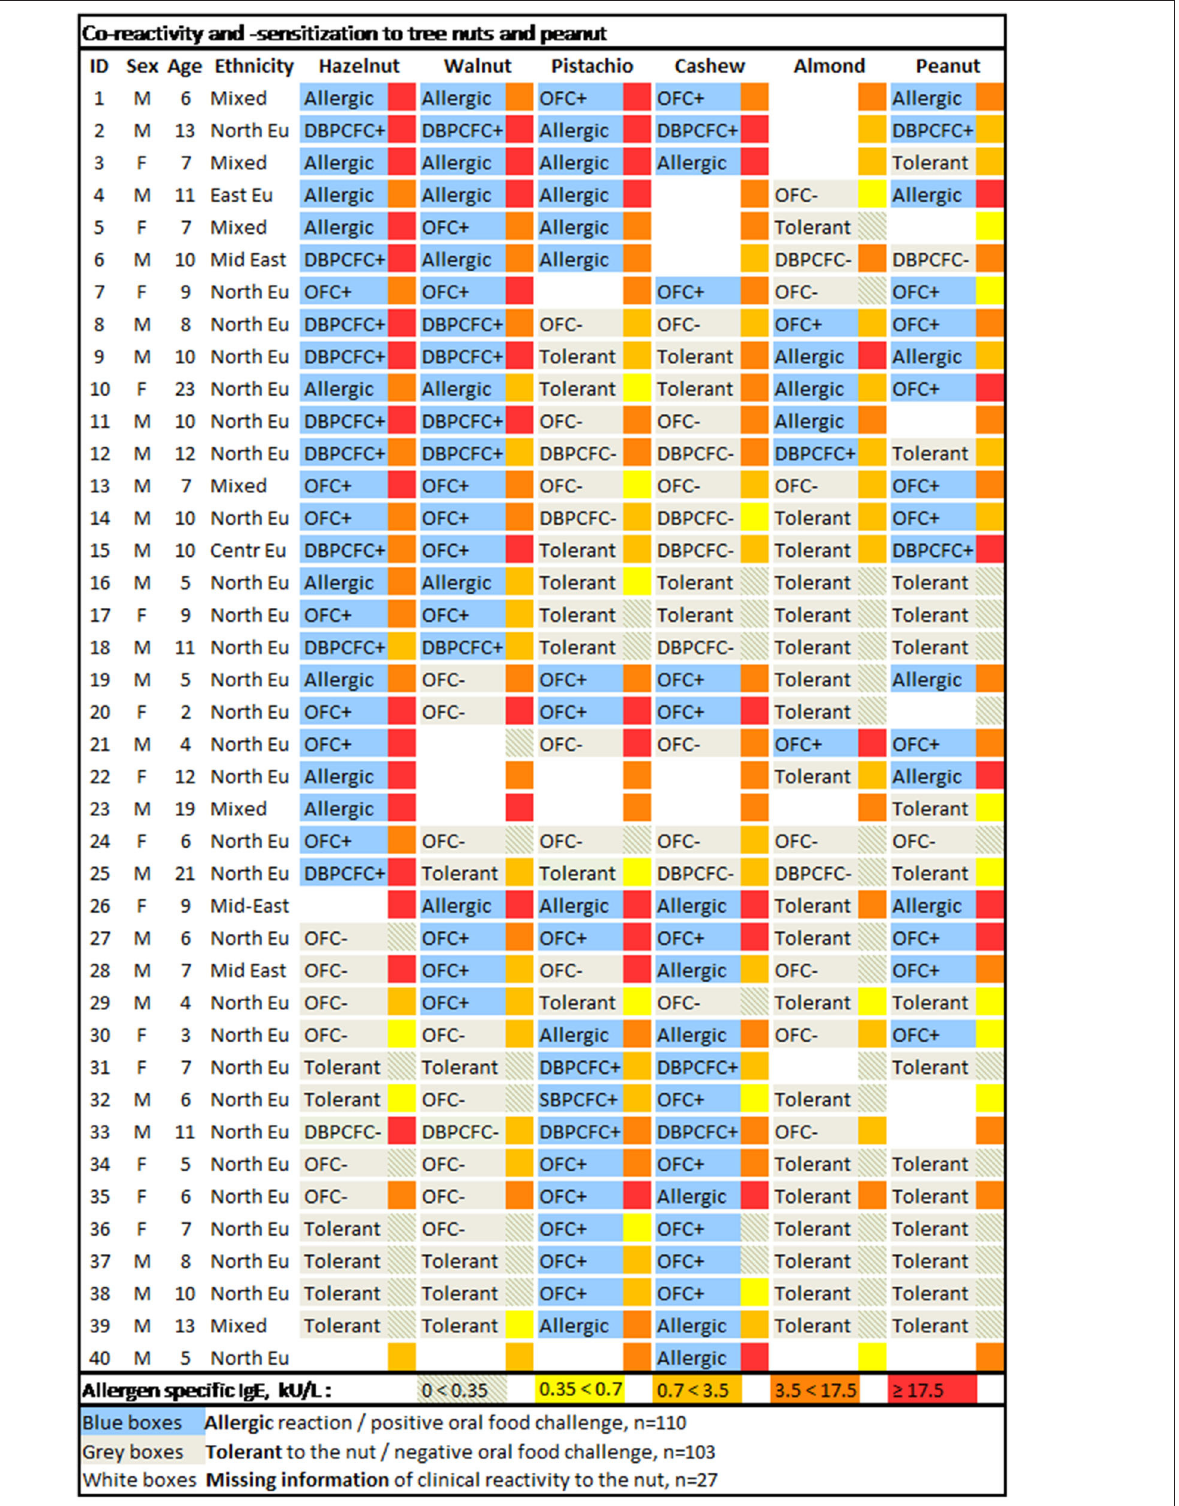
FIGURE 1 | Co-reactivity and -sensitization to tree nuts and peanut. The allergen-specific IgE levels are depicted in the narrow box adjacent to the right of the broader boxes withholding information on clinical reactivity to the specific nut. M, male; F, female; Ethnicity: North EU, Northern European (predominantly Danish); East EU, Eastern European; Mid East, Middle Eastern; Centr Eu, Central European; Mixed, Northern European and another ethnic ancestry (predominantly African).